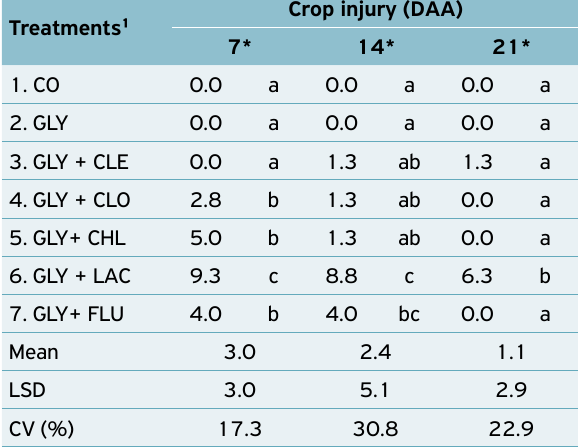
Table 4. Crop injury (%) at 7, 14, 21 and 28 days after application of RR2 soybean subjected to application of glyphosate, alone or in combination, at post‑emergence